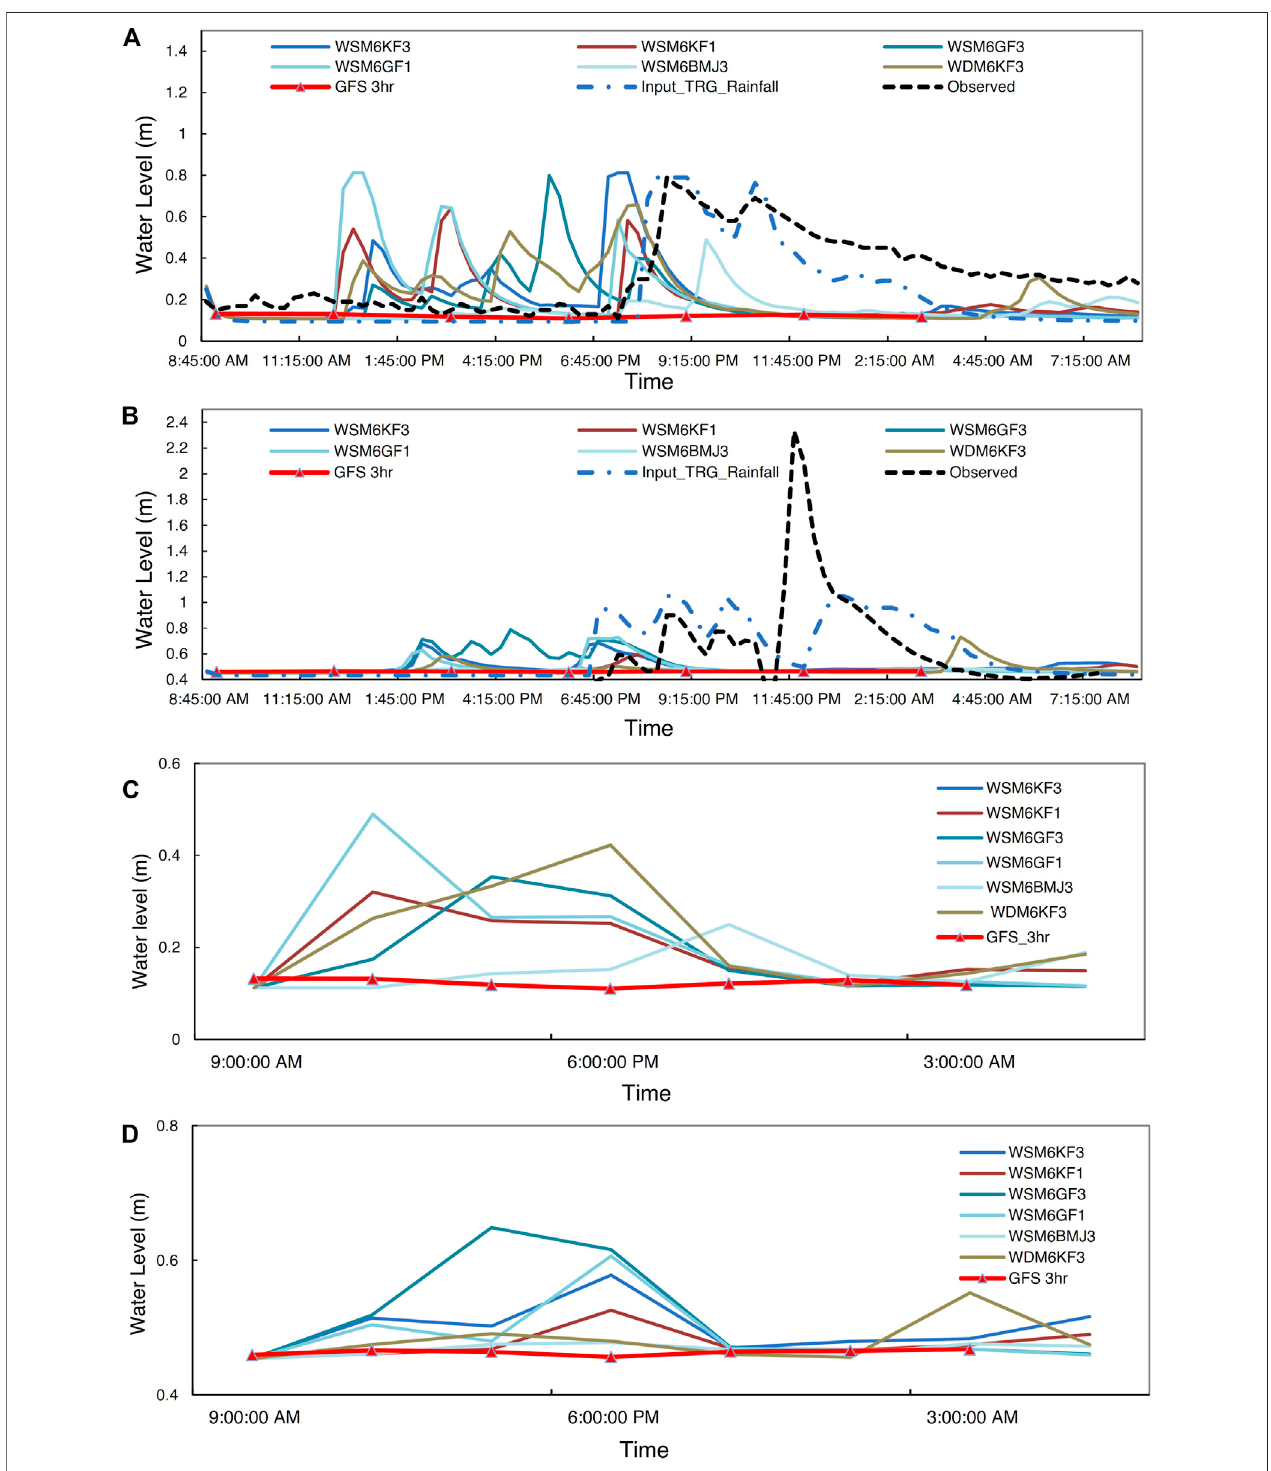
FIGURE 6 | Comparison of water level at critical water level sensor locations. (A,B) , Comparison of forecasted water level using WRF ensemble forecasts, GFS forecasts and observed rainfall with observed water levels at water level sensor location in Vrishabhavathi valley (A) and Koramangala-Chellaghatta valley (B) at 15-min interval. The water level is captured fairly using WRF forecasts than GFS forecasts. (C,D) , comparison of forecasted water levels from WRF ensemble members(3 h averaged) and GFS forecasts at three hourly intervals at water level sensor location in Vrishabhavathi valley (C) , and Koramangala-Chellaghatta valley (D) .